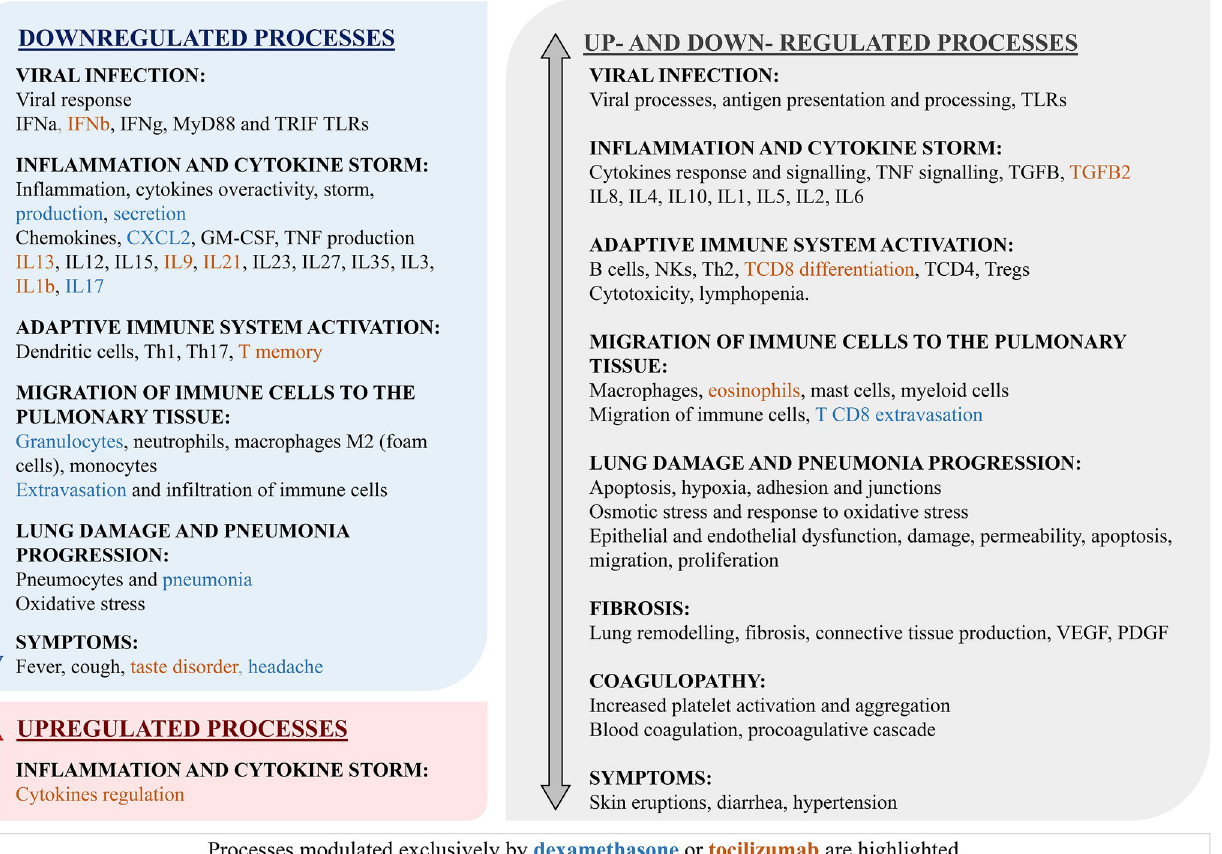
Fig 8. Summary enrichment results. Summary and overview of the biological processes modulated by the combination of dexamethasone and tocilizumab, according to our mathematical models. Proteins activated and inhibited by the pharmacological action of each drug were subjected to hypergeometric enrichment analysis independently, providing upregulated and downregulated processes respectively (modulated processes appear in both upregulated and downregulated analyses). This summary shows the COVID-19 evoked ARDS related processes modulated by the drugs. As indicated in the legend, colours indicate if the effect was shared between drugs (black) or are exclusive of dexamethasone (blue) or tocilizumab